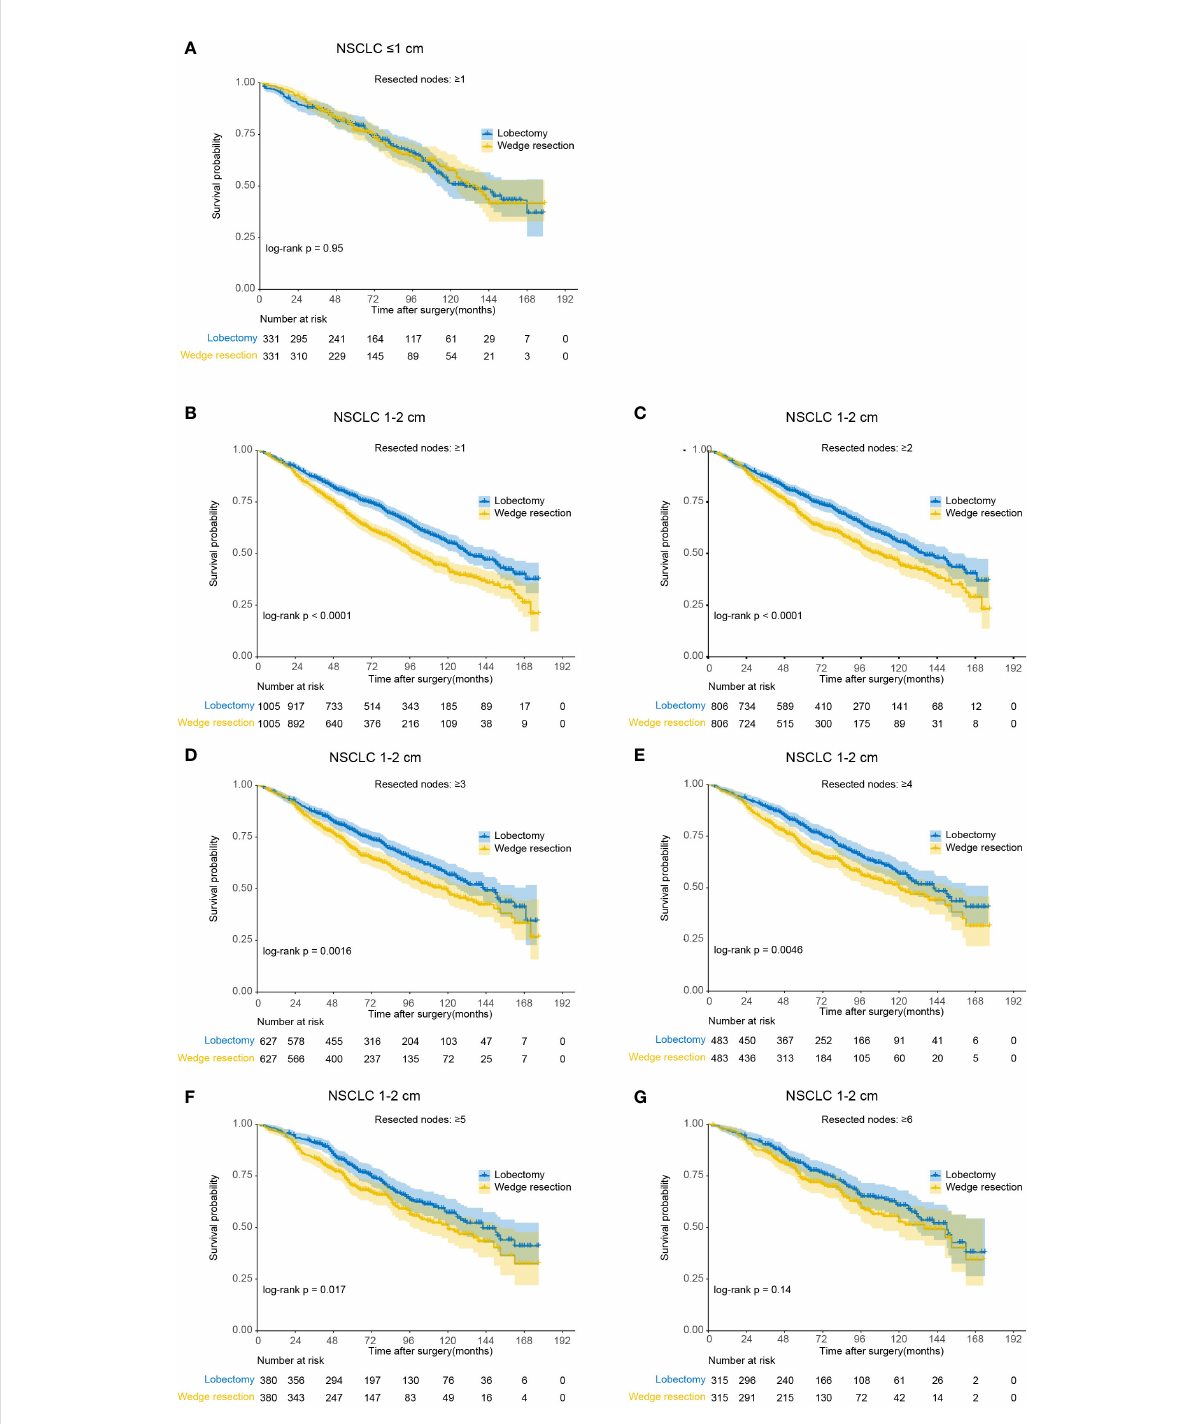
FIGURE 4 Kaplan-Meier analysis of overall survival between wedge resection and lobectomy for non-small cell lung cancer (NSCLC) with different number of nodes resected (after matching). (A) NSCLC ≤ 1 cm with ≥ 1 nodes resected; (B) NSCLC 1-2 cm with ≥ 1 nodes resected; (C) NSCLC 1-2 cm with ≥ 2 nodes resected; (D) NSCLC 1-2 cm with ≥ 3 nodes resected; (E) NSCLC 1-2 cm with ≥ 4 nodes resected; (F) NSCLC 1-2 cm with ≥ 5 nodes resected; (G) NSCLC 1-2 cm with ≥ 6 nodes